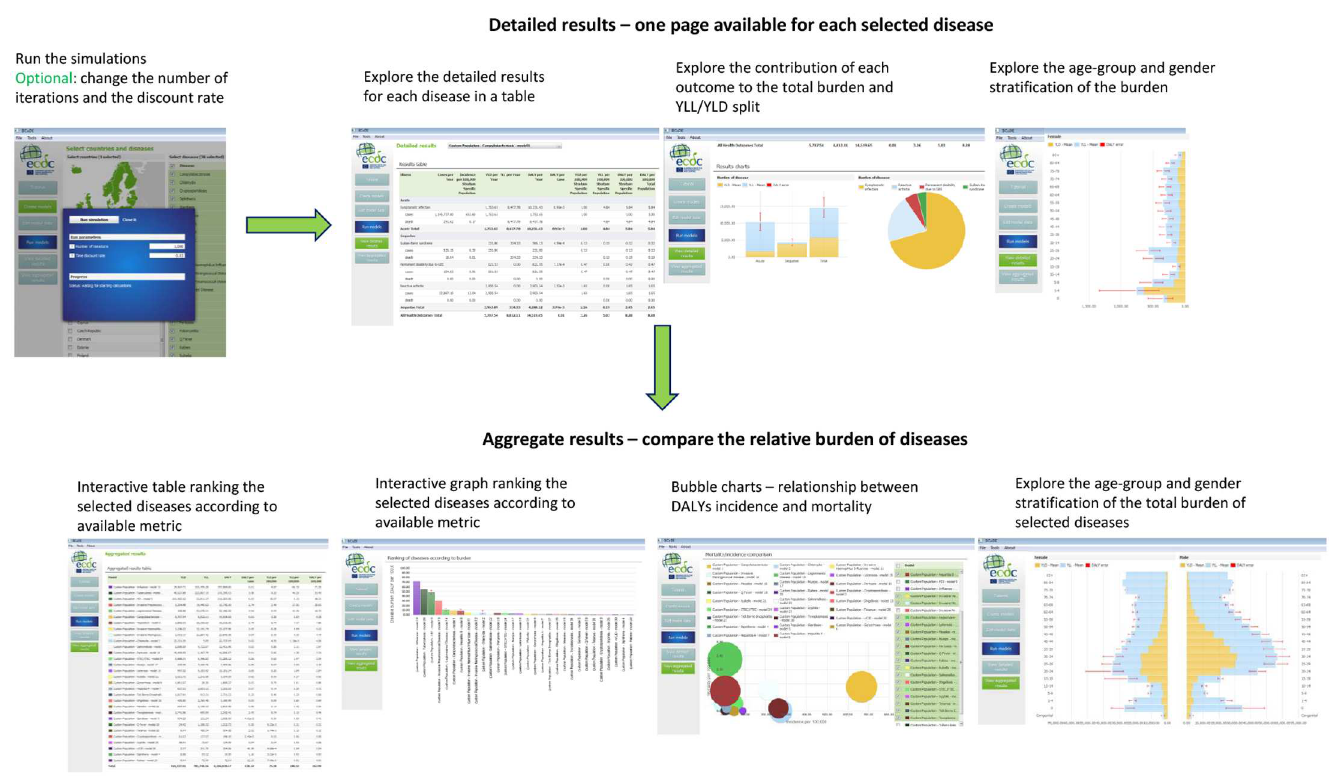
Fig 3. BCoDE toolkit: options for visualization of the